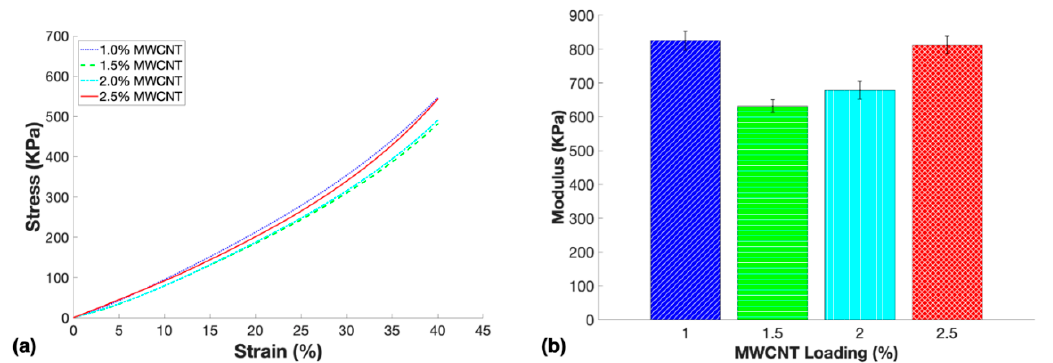
Figure 6. Mechanical characterization of the porous nanocomposites with loadings 1.0 wt. %–2.5 wt. % including: ( a ) stress vs. strain curves up to 40% compressive strain and ( b ) the average compressive modulus for each loading.